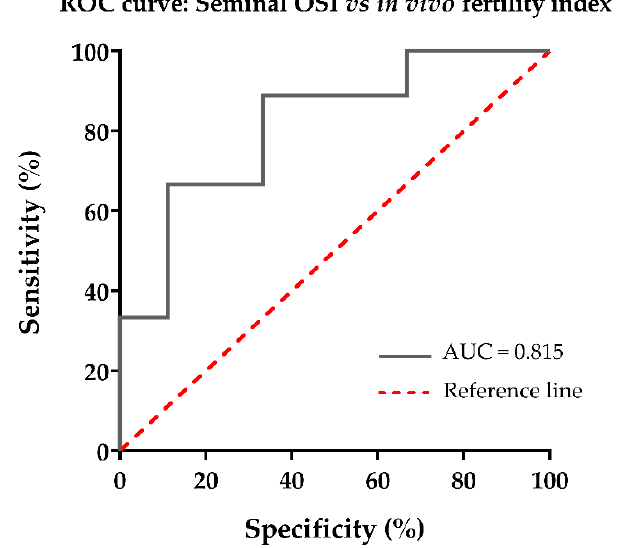
Figure 5. Nonparametric receivers operating characteristic (ROC) curve showing the ability of oxidative stress index (OSI) assessed in seminal plasma to predict in vivo fertility index of boars whose semen, as liquid-stored semen doses (17 °C), was used for artificial insemination. AUC: area under the ROC curve.